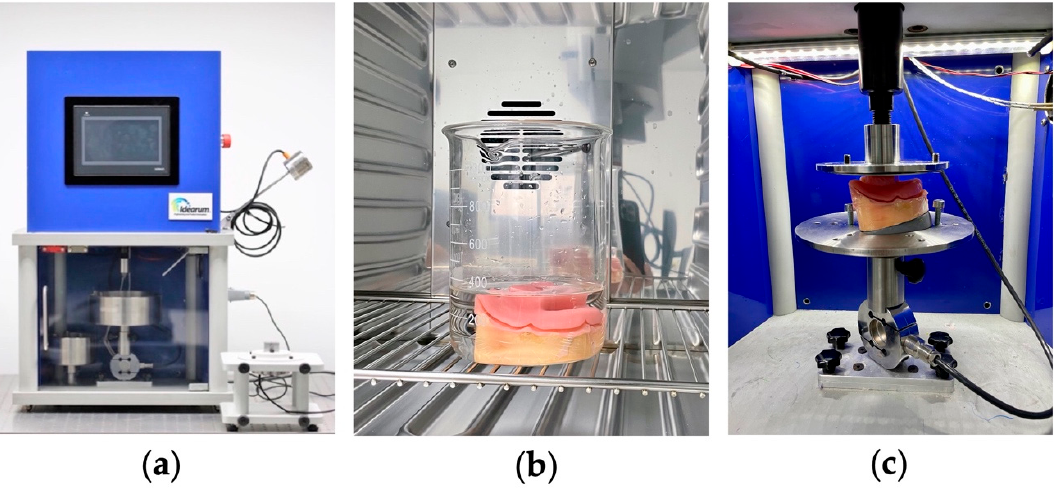
Figure 4. Traction Test. ( a ) Mechanical test machine CS ® Dental Testing Machine (Barcelona, Spain); ( b ) Simulation model with prosthetic base after placement of dental adhesive, with pressure; ( c ) Positioning of the simulation model in the test machine.